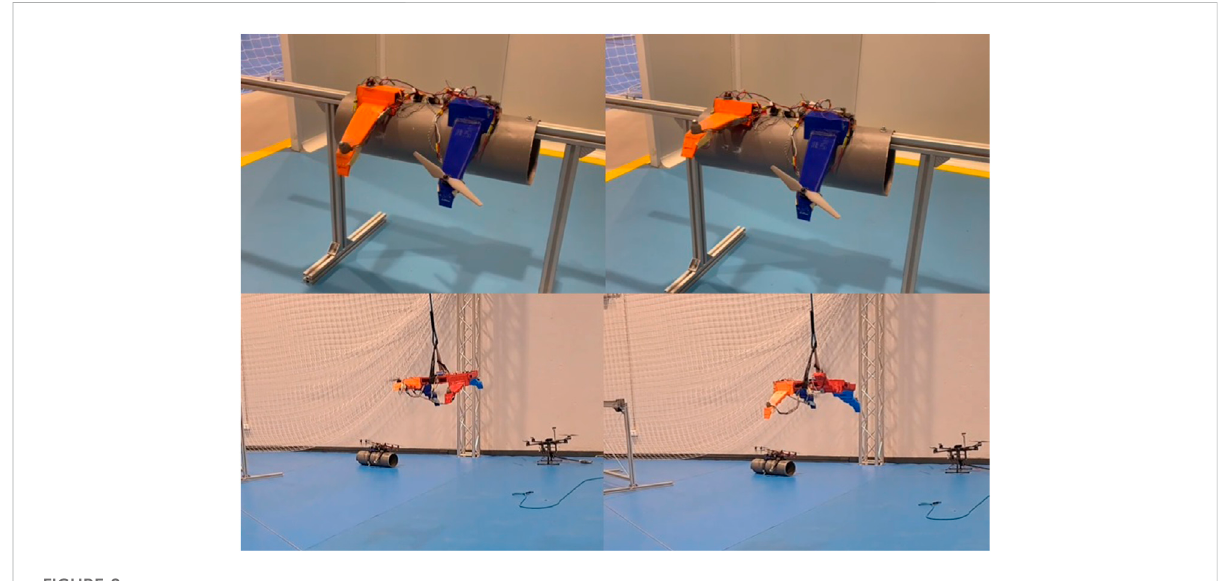
FIGURE 8 Prototypesusedfortheexperiments.Theupperimagescorrespondtothetestbenchusedfortheanalysisoftheaerodynamiceffects,whilethe bottom images correspond to the experiments of the soft drone during the tuning process using the Ziegler-Nichols